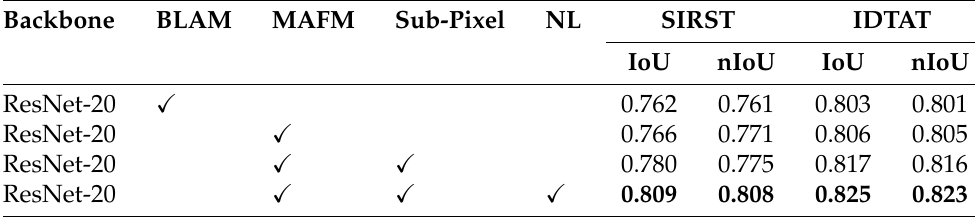
Table 7. Ablation study on the whole